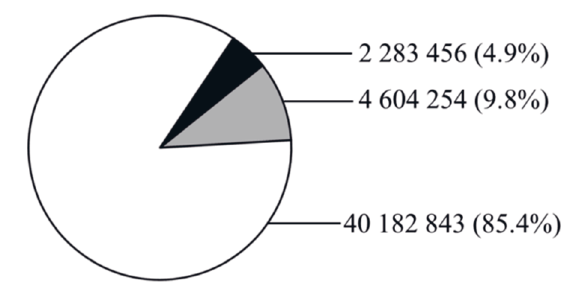
Figure 2. Comparison of the aquaculture production of marine fish species ( black ) with those of diadromous ( grey ) and freshwater ( white ) species in 2013. The first number is the total production followed by the percentage in parentheses.